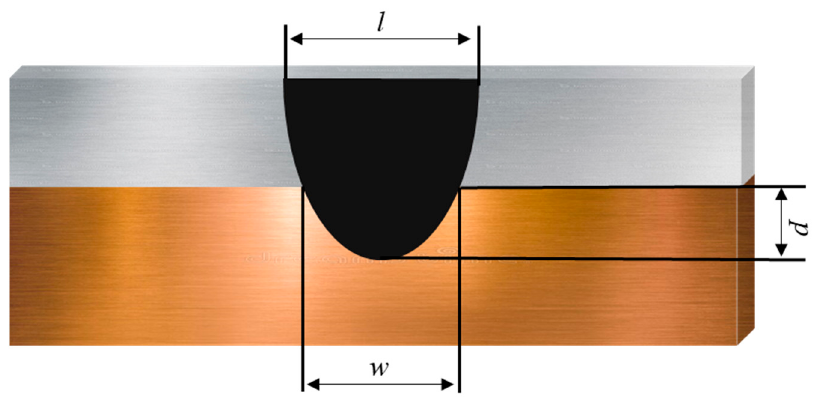
Figure 3. Characteristics of weld geometry.